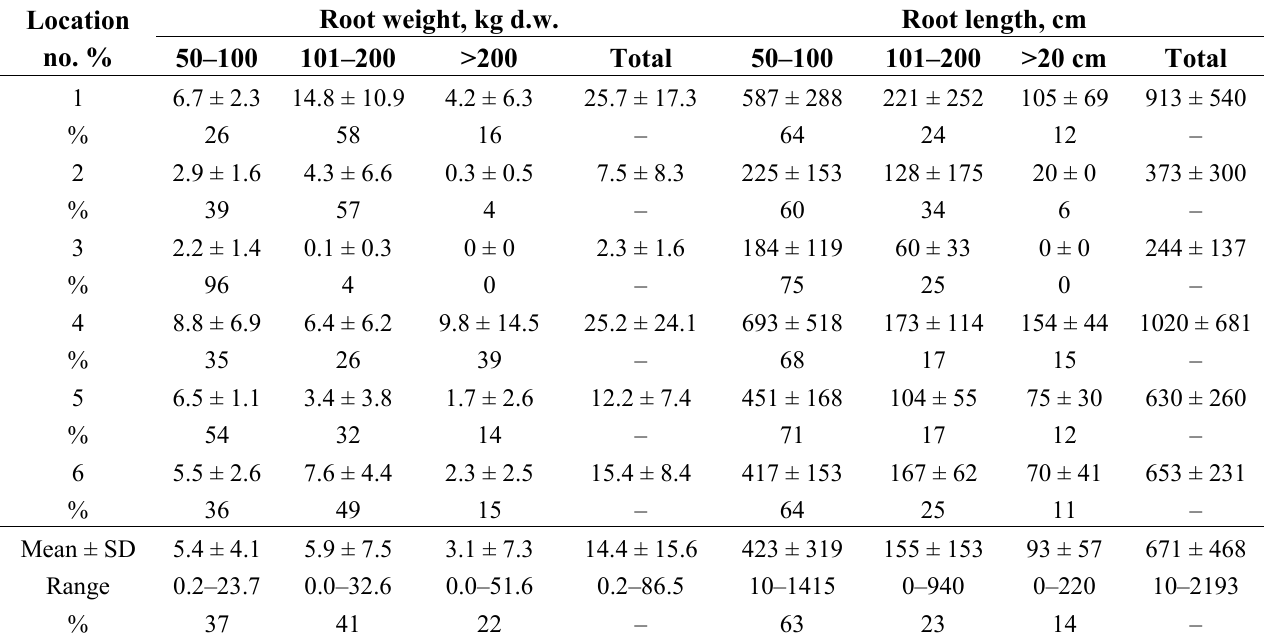
Table 6. Mean root weight (kg) and root length (cm) of different root diameters (mm) in poplar stands and mean percentage of total root weight and